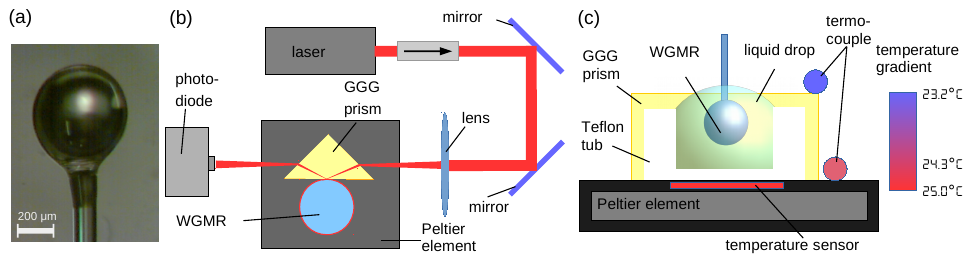
Figure 1. The scheme of the experimental system. ( a ) Silica microsphere whispering gallery mode resonator (WGMR) with a diameter of (509 ± 3) µ m. ( b ) View from the top with a Gadolinium Gallium Garnet (GGG) coupling prism to excite the resonance of whispering gallery mode resonator (WGMR) using a 780 nm external cavity diode laser (ECDL), a Peltier element to control temperature, and a photodiode to process the signal transmitted in the air. ( c ) Side view where a Teflon tub is viable to contain the liquid drop, which can be situated above the rim because of liquid tension